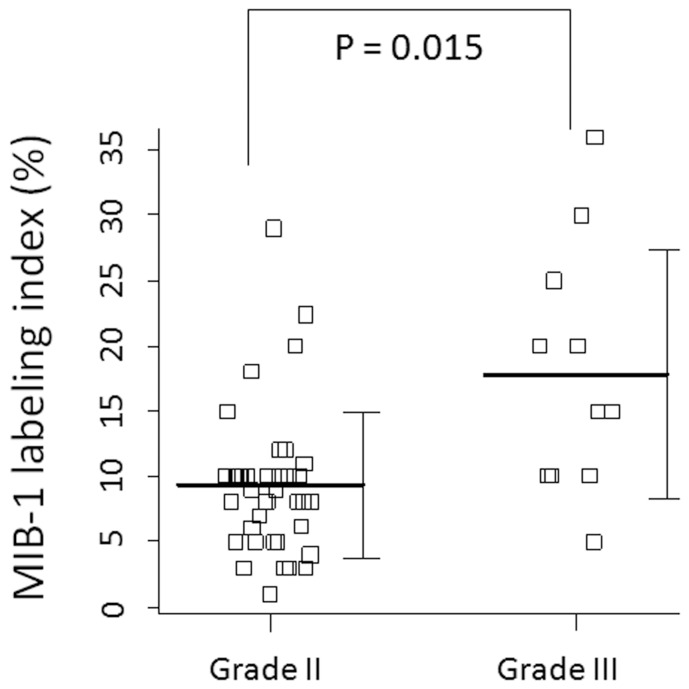
The MIB-1 labeling index of Grade II and Grade III meningioma.The mean MIB-1 labeling index of Grade II and Grade III meningioma are 9.3% and 17.8%, respectively, and these mean value are significantly different (p = 0.015). The bars represent the mean values and standard deviations.